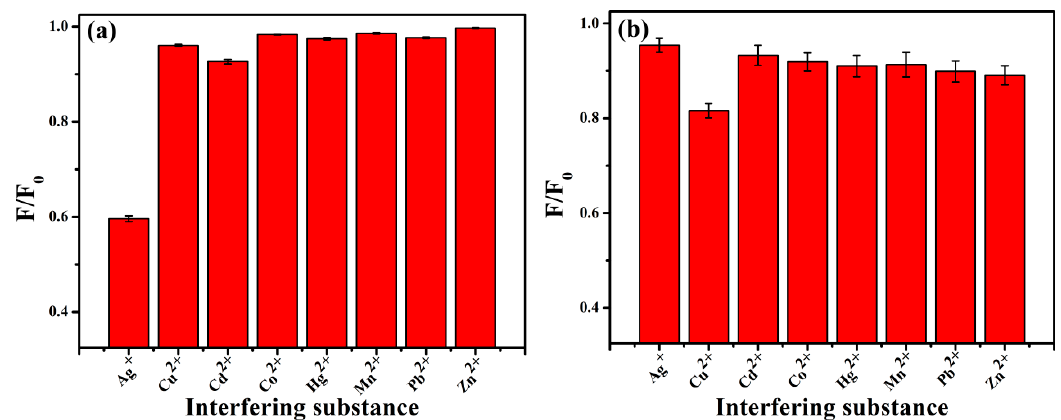
Figure 6 . Selectivity of two kinds of quantum dots for different metal ions. F 0 is the fluorescence intensity of the quantum dots; F is the fluorescence intensity when metal ions are added; F/F 0 is the fluorescence quenching efficiency of the quantum dots. ( a ) Selectivity of N-CQDs for different metal ions (25 μ M); ( b ) selectivity of cadmium selenide (CdSe) quantum dots for different metal ions (25 μ M).